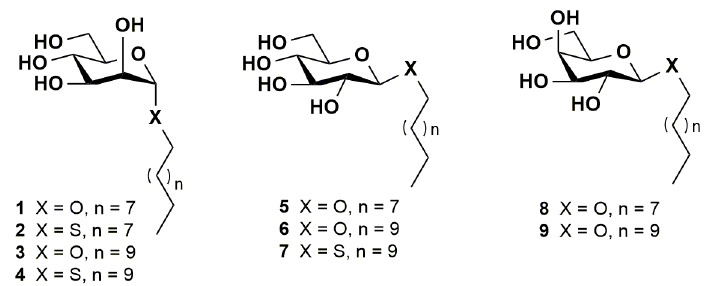
Figure 1. The previously synthesized nonionic